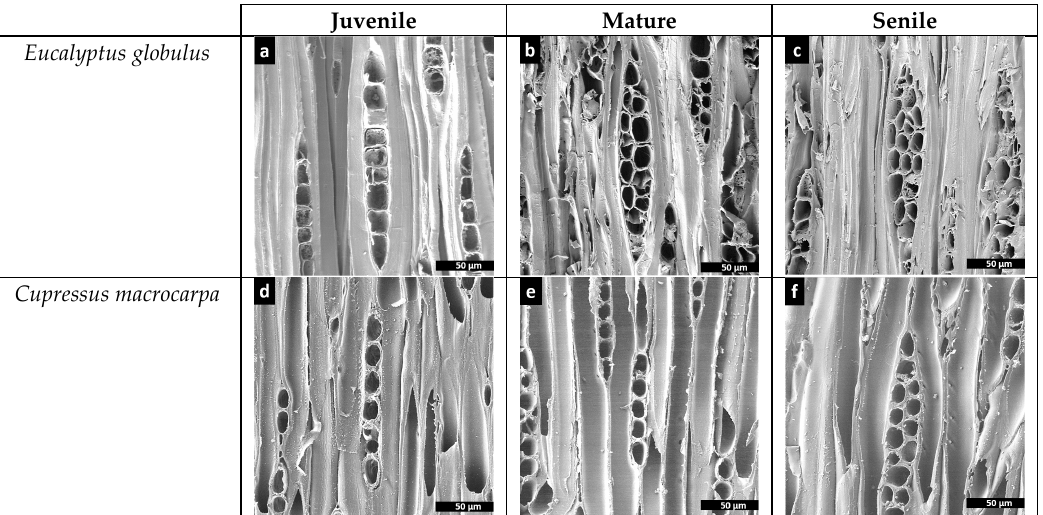
Figure 8. Microphotographs of tangential cuts obtained in SEM for the comparison of green tissue-microstructure transitions in Eucalyptus globulus and Cupressus macrocarpa per age group. ( a )–( c ) show the transitions of ray parenchyma cells in Eucalyptus globulus , whereas Figures ( d ) to ( f ) show the corresponding transitions for Cupressus macrocarpa .